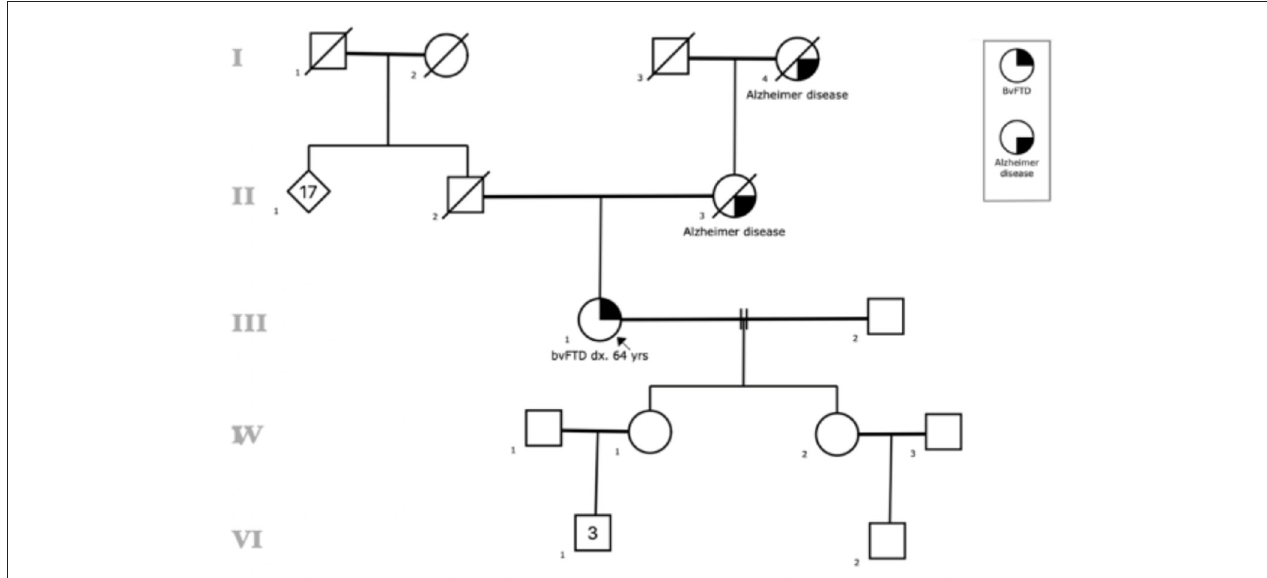
FIGURE 1 | Family Pedigree of the patient with C90RF72 expansion. Circles: female, square: males. Black symbols reflect individuals affected with Alzheimer disease or bvFTD, lines represent those who are deceased. The arrow identifies the proband.